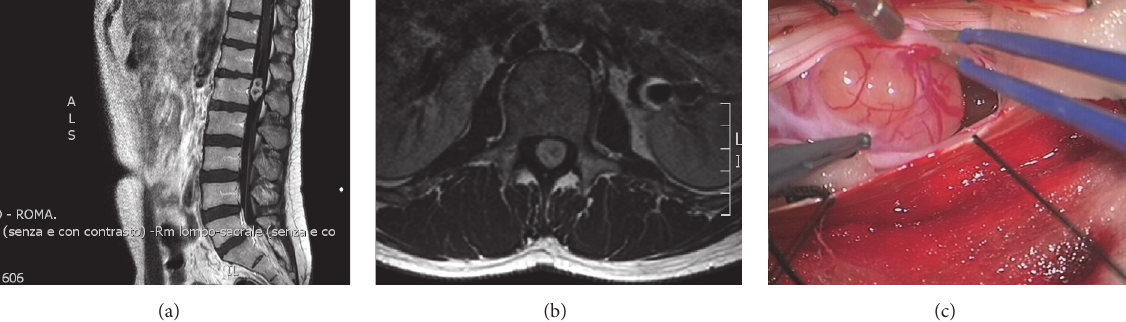
Figure 1: (a) Sagittal and (b) axial preoperative contrast enhanced MRI scan. (c) Intraoperative image of the lesion at gross examination resembles an ordinary schwannoma. Note the “target” pattern in (a) and the finely heterogenous contrast enhancement in (b), consistent with the typical aspect of an ancient schwannoma.